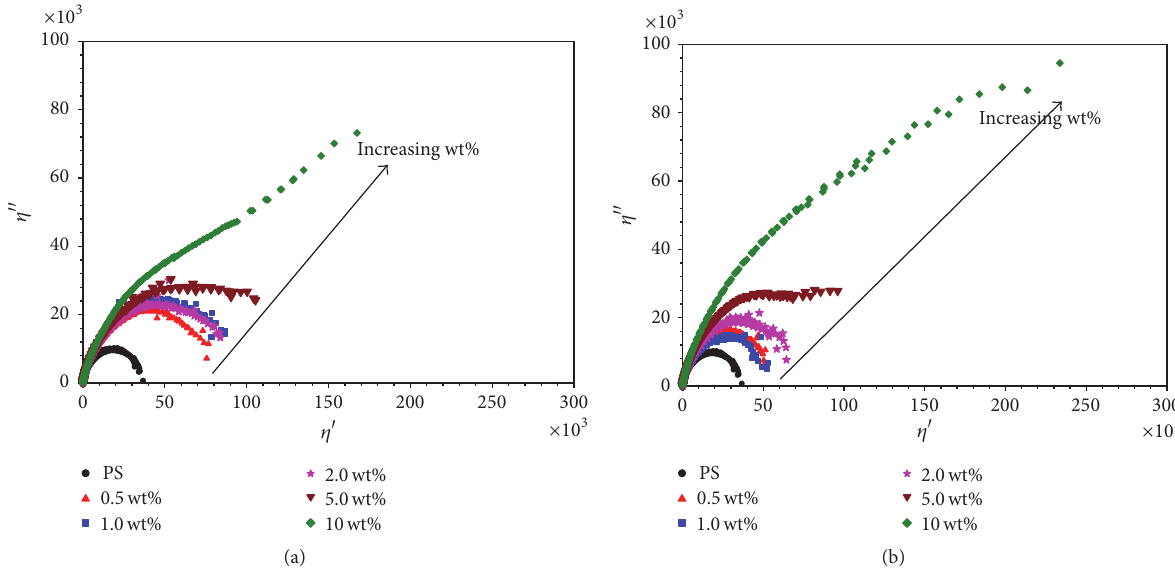
Figure 4: Cole-Cole plot ( 𝜂 󸀠󸀠 versus 𝜂 󸀠 ) of blend of neat PS with (a) PS/nanofiber and (b) PS/nanosheet using master curve.